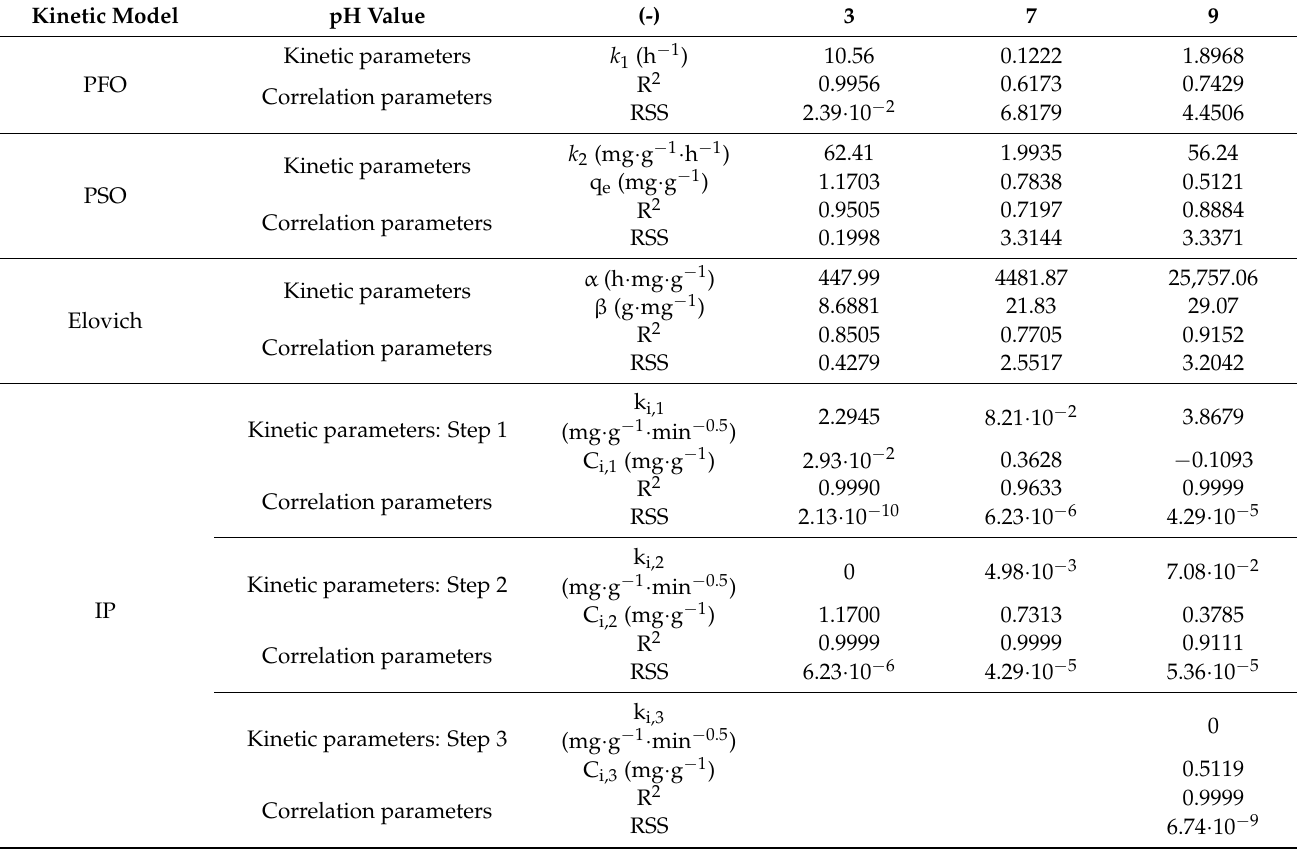
Table A1. Adjusted kinetic and correlation parameters of different kinetic models fitted to the